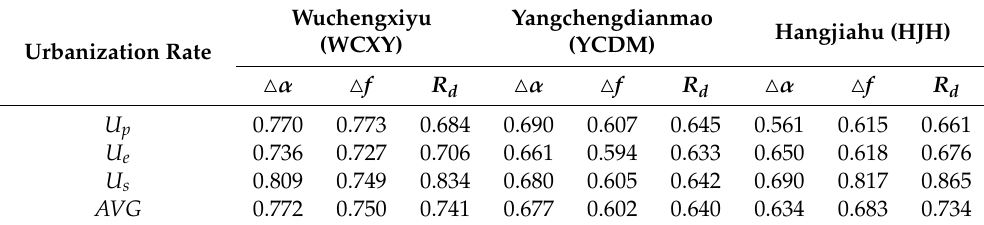
Table 4. Grey Correlation between the river networks changes and urbanization level in Wuchengxiyu (WCXY), Yangchengdianmao (YCDM) and Hangjiahu (HJH) in the 1960s, 1980s, and